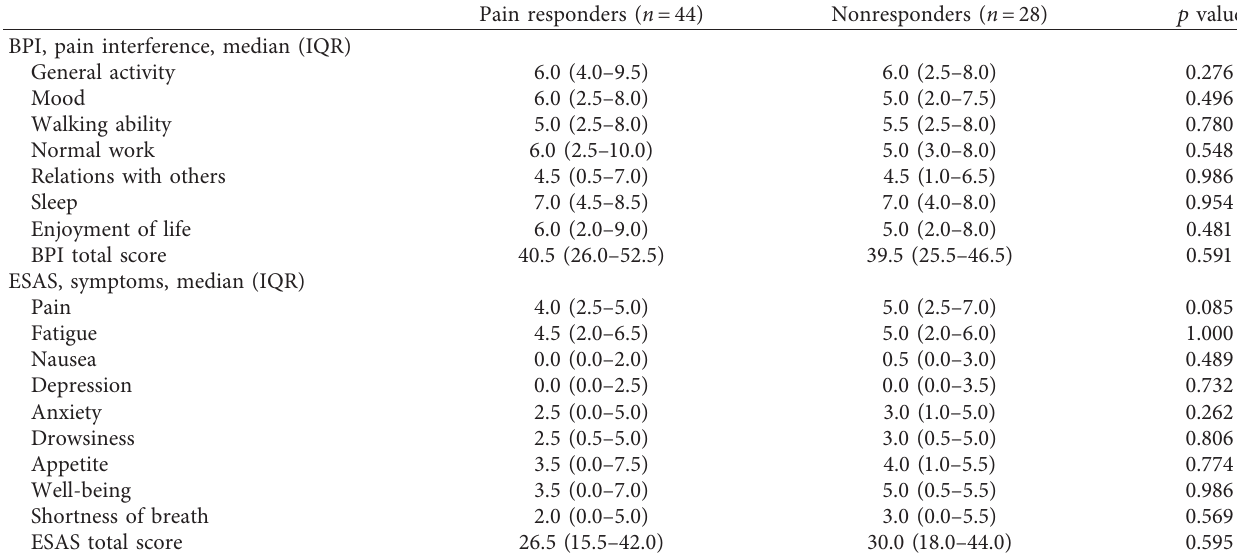
Table 4: Pain interferences and other symptoms’ difference between pain responders and nonresponders at